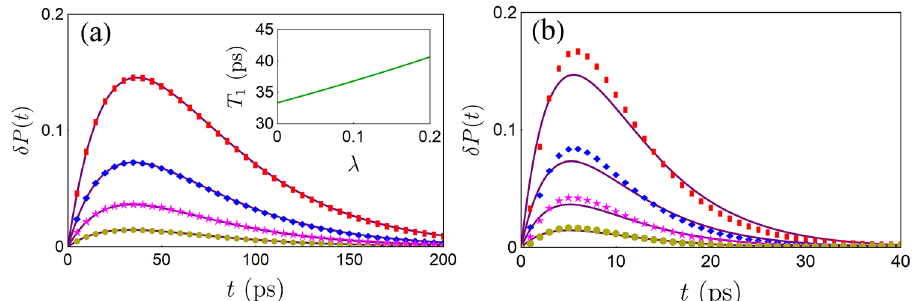
Figure 1. ( a ) δ P ( t ) is plotted as the function of time with different steer parameters: (cid:31) = 0.02 (yellow circles), (cid:31) = 0.05 (magenta stars), (cid:31) = 0.1 (blue diamonds) and (cid:31) = 0.2 (red squares). The purple solid lines are obtained from the Wigner–Weisskopf approximate expression of P ( t ) − P 0 ( t ) . The insert curve shows the relation between T 1 and (cid:31) . The initial state of the TLS is | e �� e | , other parameters are chosen as ω 0 = 100 cm − ω c = 10cm − 1 and α = 0.15cm − 1 . ( b ) The same with ( a ), but ω c = 1.5cm − 1